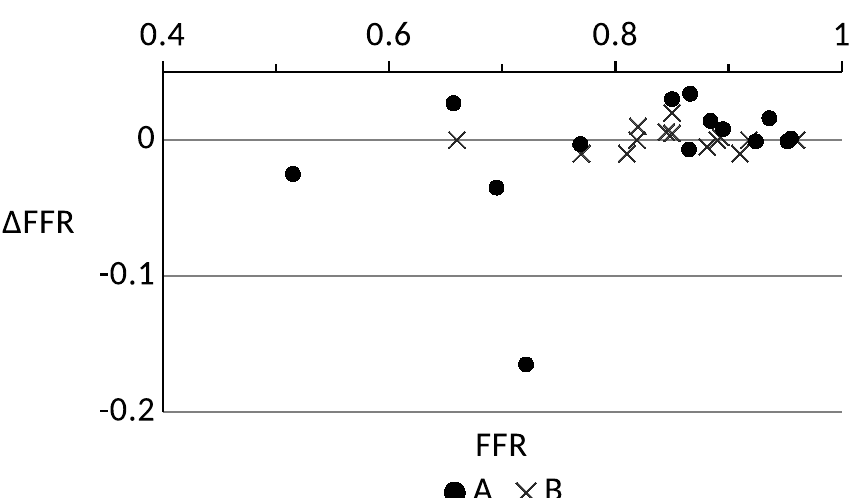
Figure 4. Difference between the FFRs, which were calculated for the full trees and reduced trees (A—recursive algorithm, B—terminal points algorithm).